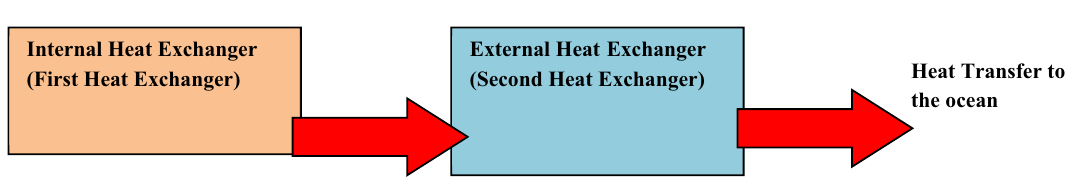
Figure 6. Relations between internal heat exchanger and external heat exchanger in existing